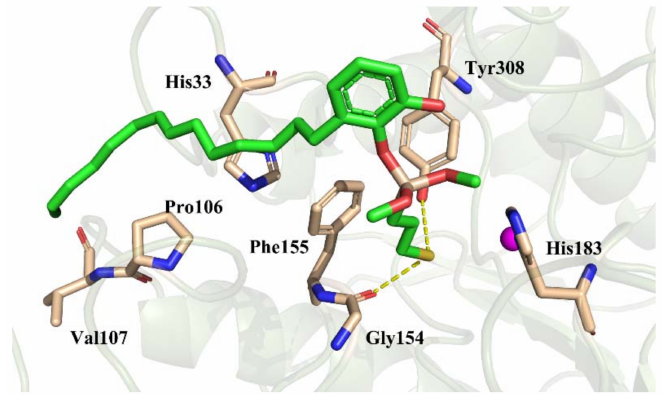
Figure 8. Molecular docking modeling of compound 1 in the active site of HDAC2. In the picture, the ligands (green) and the key residues (wheat) are denoted by sticks, and the protein smudge color by cartoon. A yellow dotted line represents a hydrogen